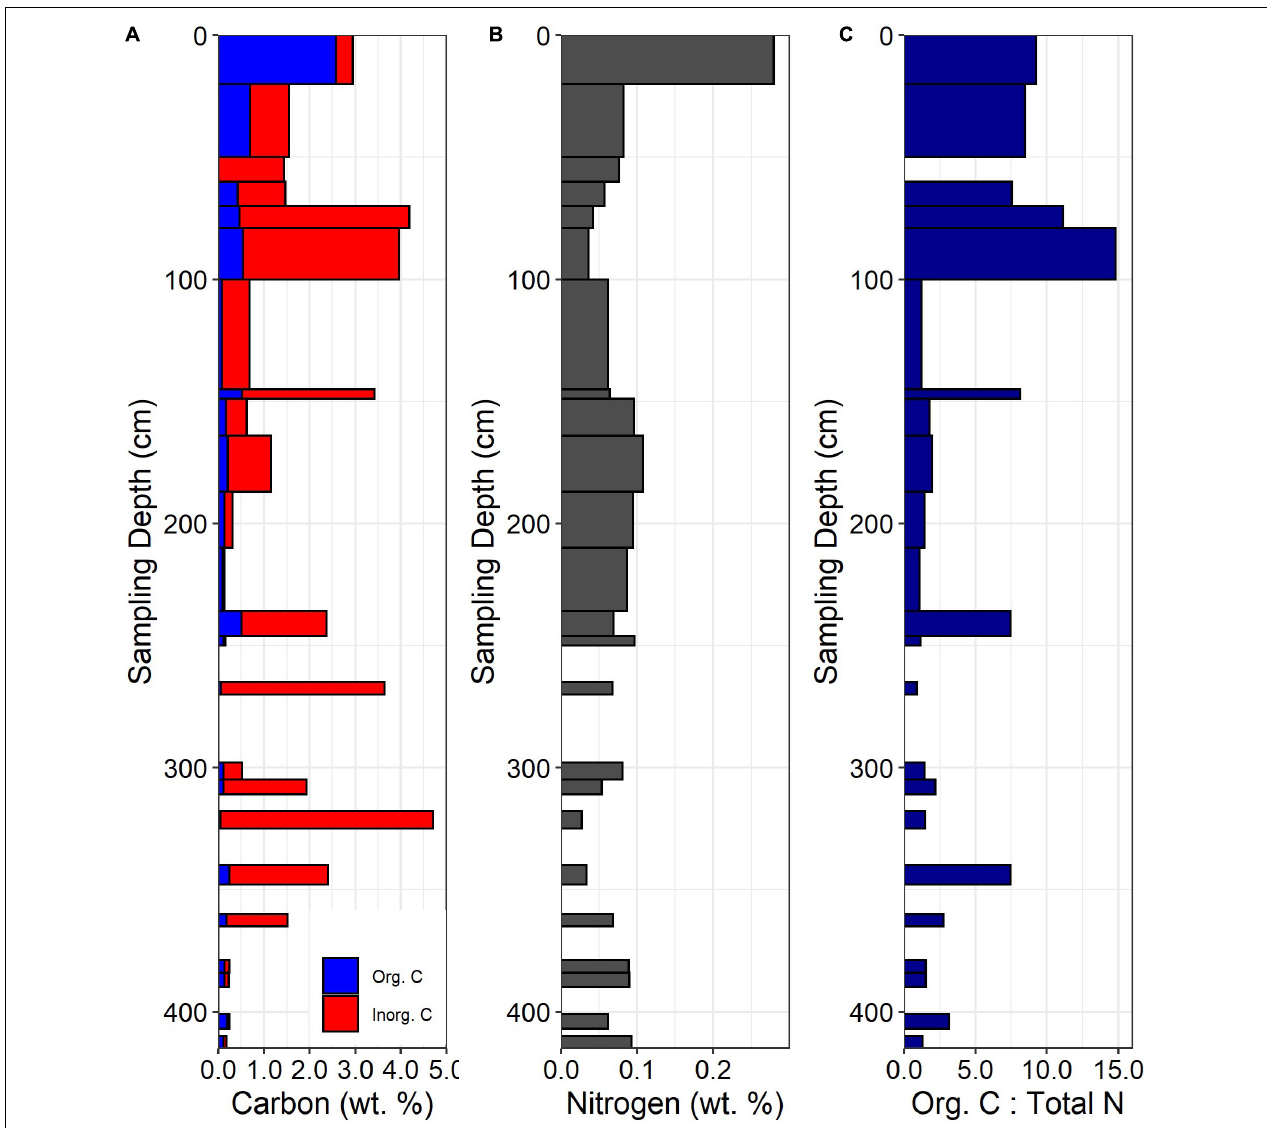
FIGURE 3 | (A) Total C concentrations, (B) Total N concentrations, and (C) organic C: total N for the ridgecrest soil pit. Gaps in data indicate samples not taken at depth (gaps occurring below 250 cm) or because there was no organic C measured in the sample (50–60